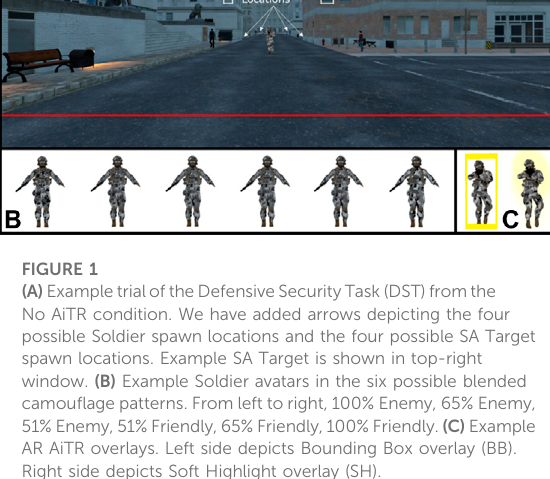
available Unity asset package (Kronnect, 2021), depicted in Figure 1C. Consistent with previous research demonstrating